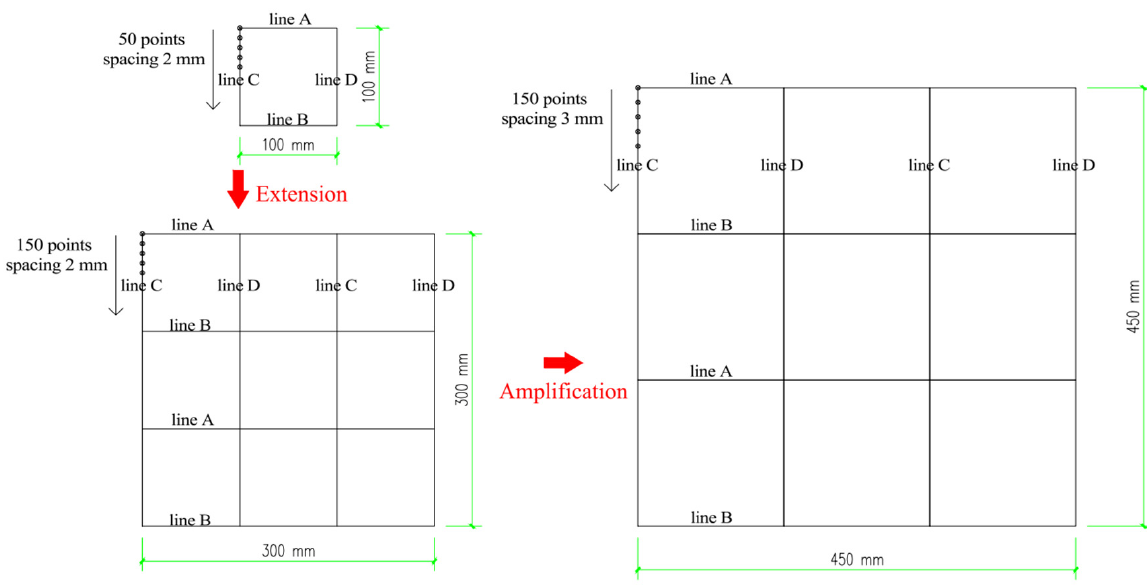
Figure 6. Pavement grid setting after the extension and the amplification